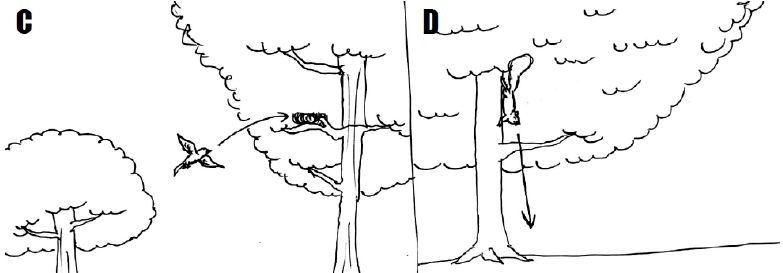
Figure 8. Examples of the pictures used in Activity B of the second module. C : Der Spatz fliegt hinauf; D : Das Eichhörnchen steigt